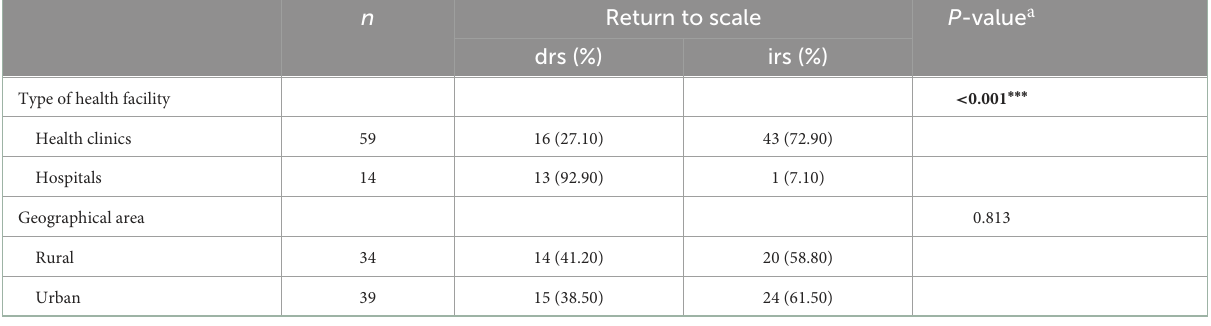
TABLE 7 Return to scale categories by type of health facility and geographical area for variable return to scale (OTE) inefficient DMUs ( n = 73). n Return to